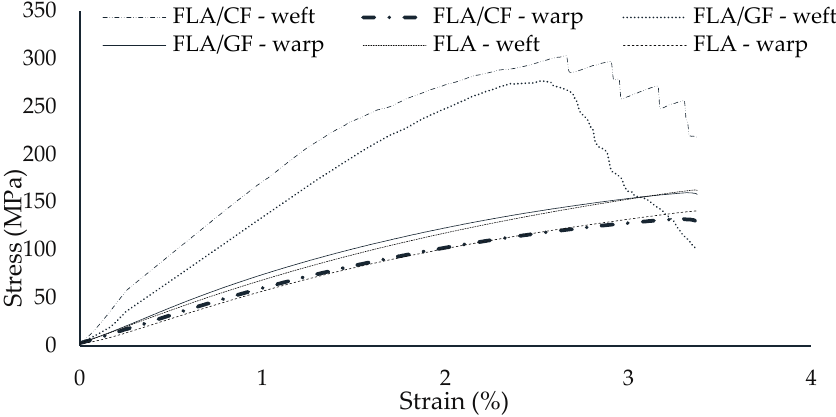
Figure 11. Stress-strain curves of the flax composite with twill weaved textile and hybrid textiles composing of flax and carbon as well as flax and glass fibers.